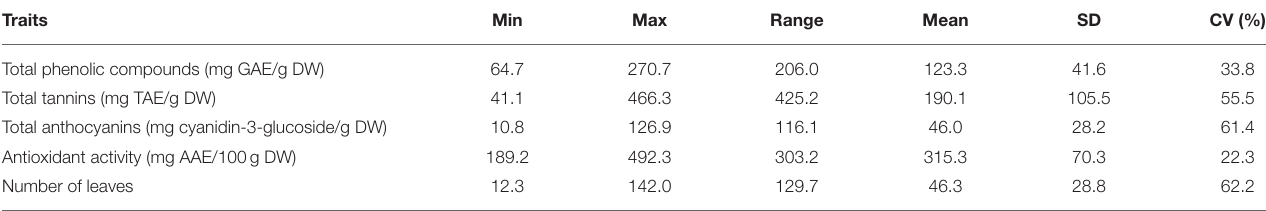
TABLE 2 | Descriptive statistics for dietary phytochemicals and morphological traits of the 33 accessions of Gynandropsis gynandra . Traits Min